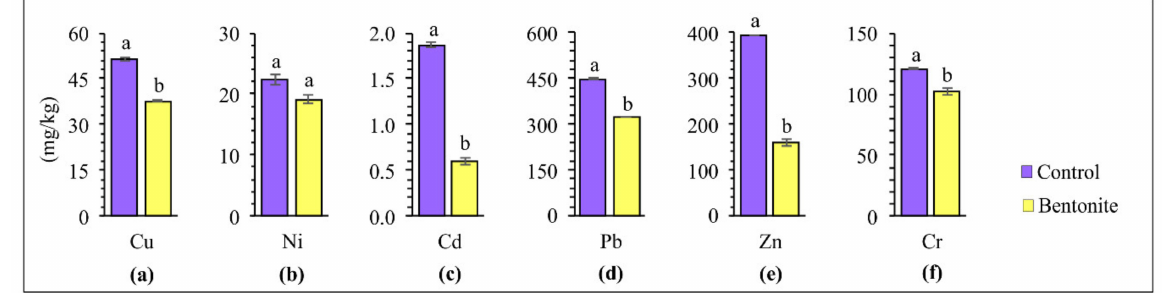
Figure 3. Content of copper ( a ), nickel ( b ), cadmium ( c ), lead ( d ), zinc ( e ), and chromium ( f ) in above- ground parts of tested plants. Different letters indicate significant differences ( p < 0.05) between the control and bentonite samples.